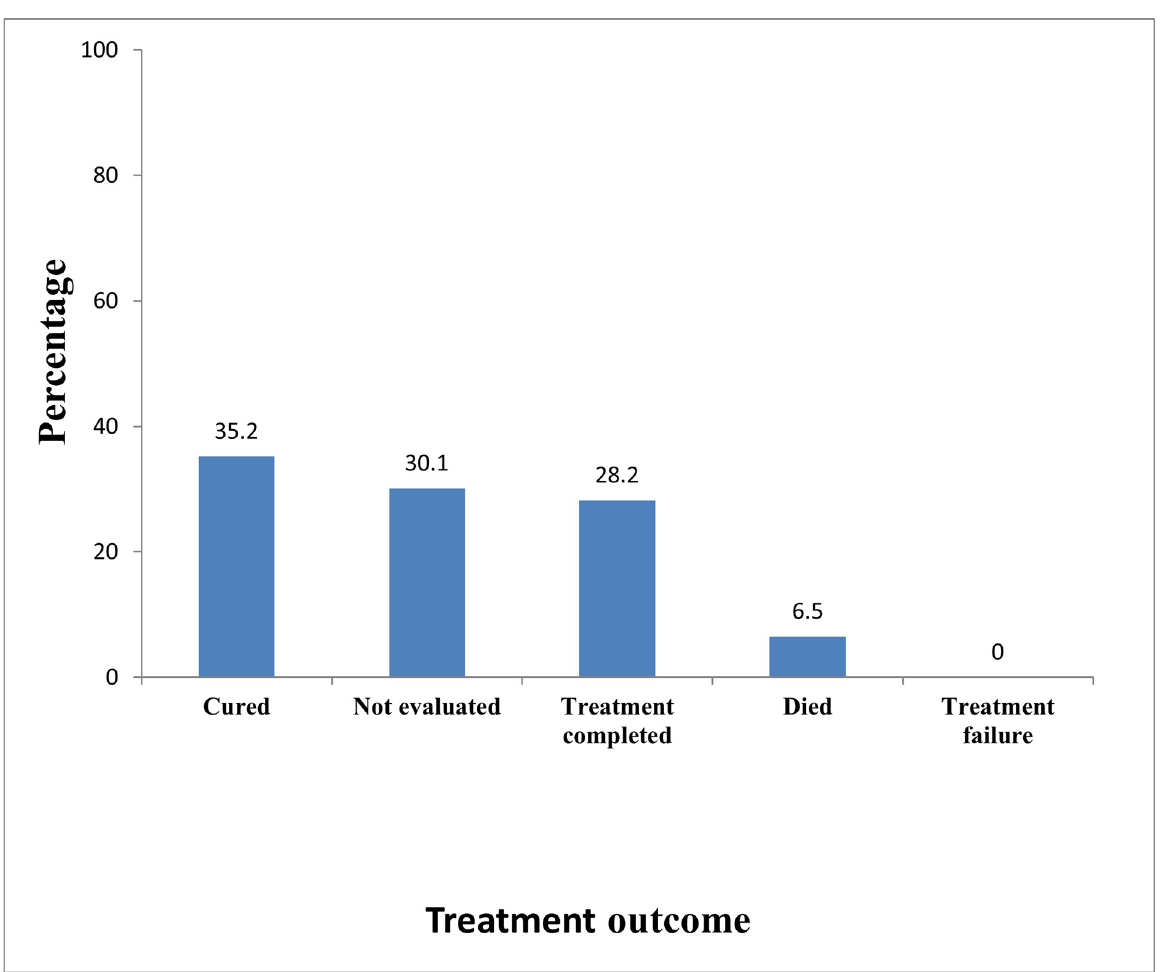
Fig 1. Treatment outcome of TB cases in the five main prison settings in Bauchi State from January 2014 to December 2018.